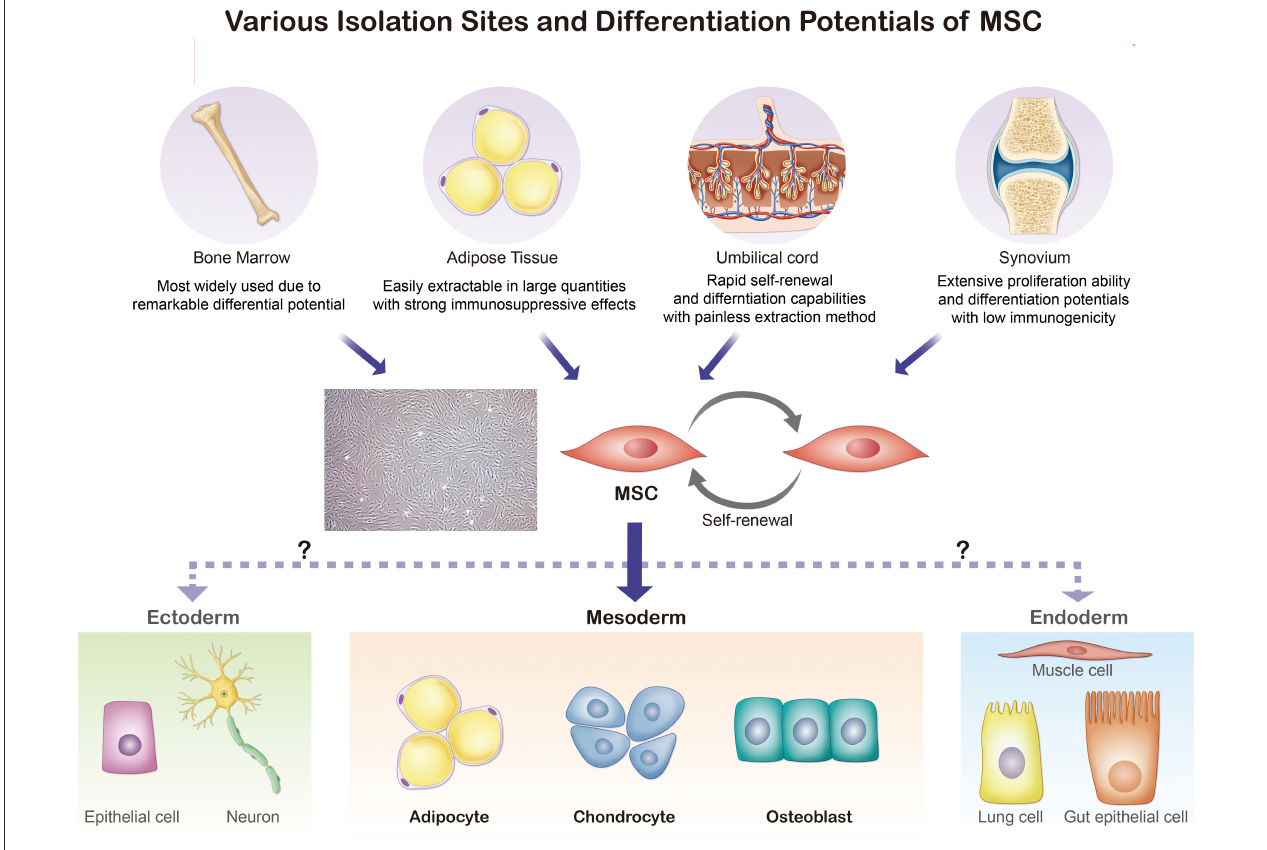
FIGURE 1 | Various isolation sites and differentiation potentials of MSCs. Bone marrow, adipose tissue, umbilical cord, and synovium are common sites for MSC extraction. The isolated MSCs can be differentiated into adipocytes, chondrocytes, myocytes, and